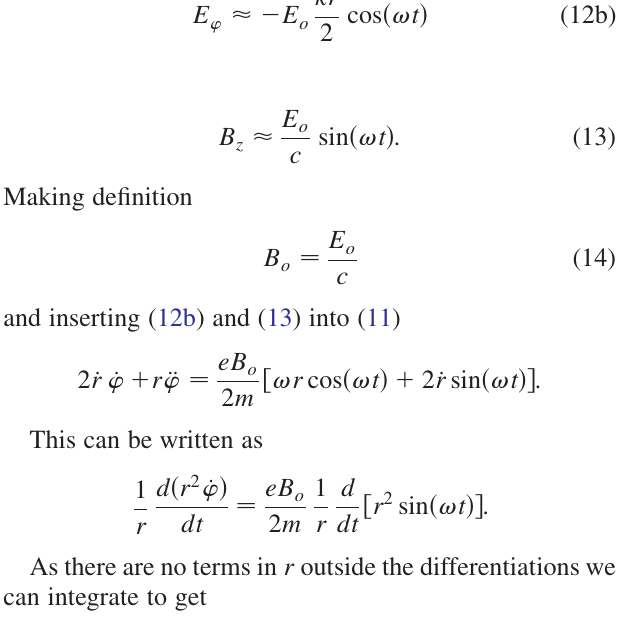
FIG. 1. HM mode transverse electric field determined from 11 (7) and (8) with iris walls shown in red and example electron trajectory in